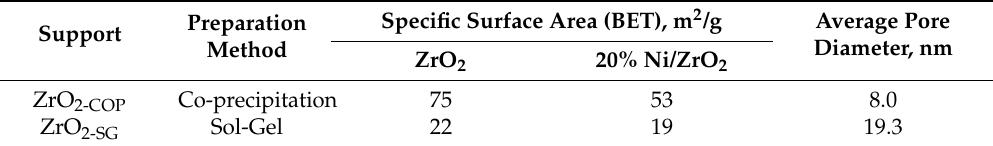
Figure 4. Temperature-programmed reduction (TPR) analysis of the 20% Ni catalysts supported on ( a ) coprecipitated and ( b ) sol-gel Ni/ZrO 2 catalysts. Table 2. Nitrogen physisorption analysis. Specific surface area and average pore